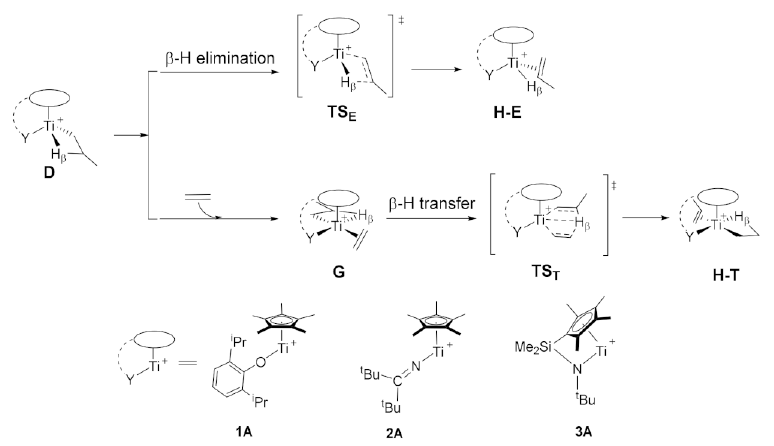
Figure 9. The proposed termination process of ethylene polymerization catalyzed by half-titanocenes.